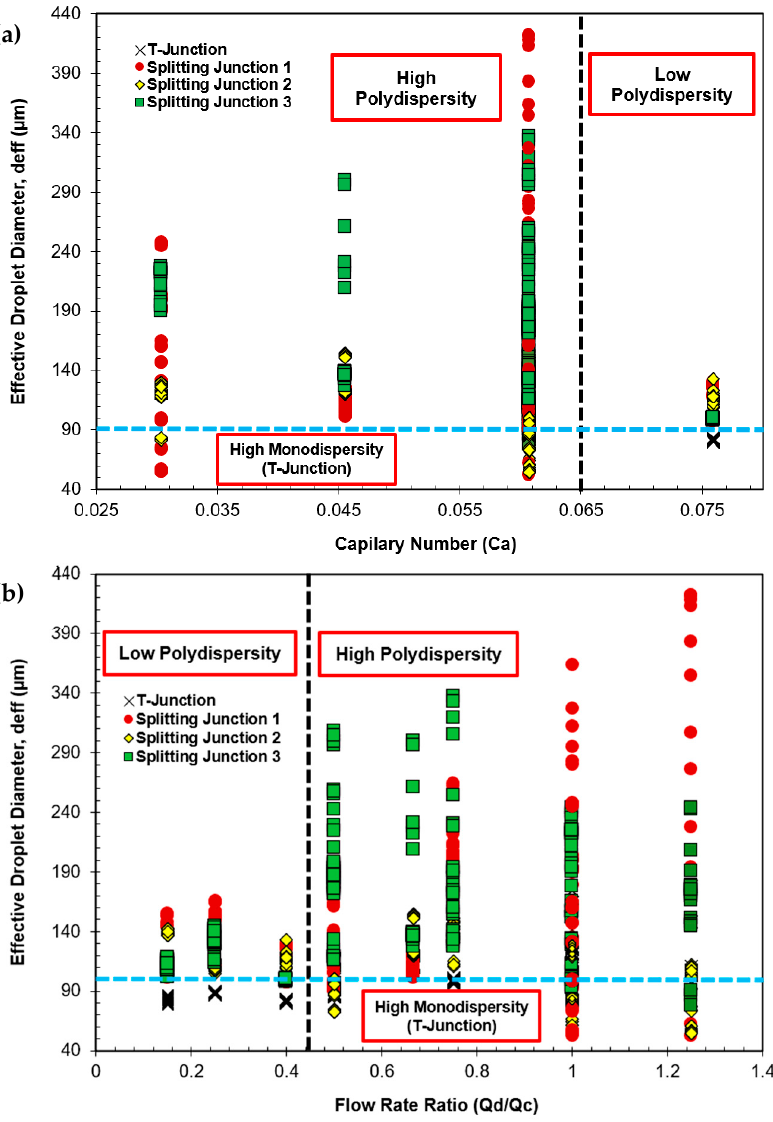
Figure 14. Distribution of droplet size in various regions of interest with respect to: ( a ) Capillary number and ( b ) flow rate ratio at symmetrical bifurcating junction.